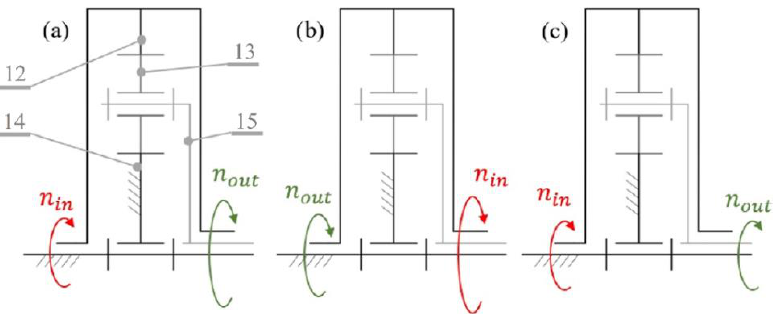
Figure 3. Diagrams of planetary gears for different ratios: ( a ) first gear, ( b ) second gear, ( c ) third gear; 12—internal teeth, 13—planetary gear, 14—sun gear, 15—carrier, n in —input rotational speed and n out —output rotational